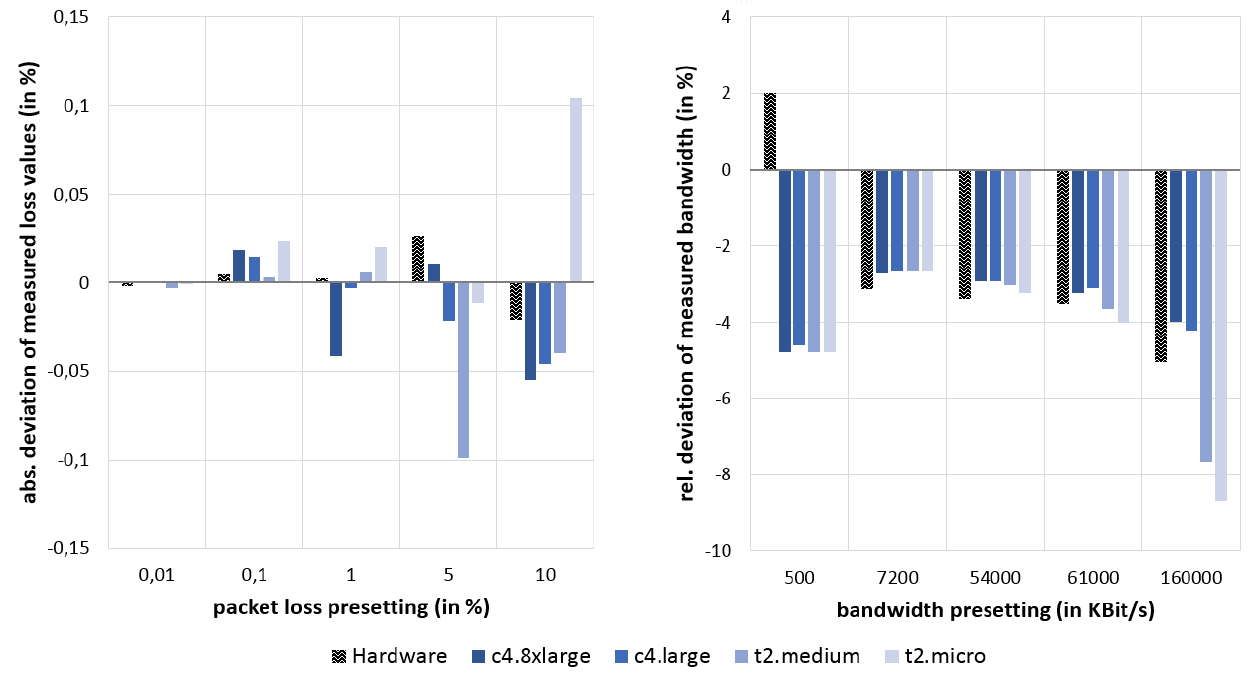
Figure 4: To evaluate the accuracy we determined the deviation of configured and actually measured network parameters in hardware and virtual environments with four different instance